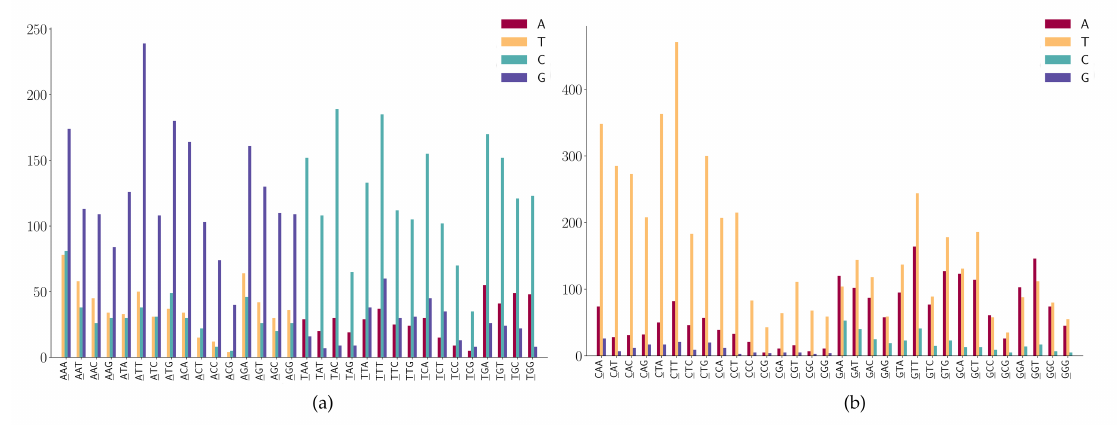
Figure 7. SNP frequency at the first positions of the 3-mer motifs. ( a ) A or T is at the first position of 3-mer motifs. ( b ) C or G is at the first position of 3-mer